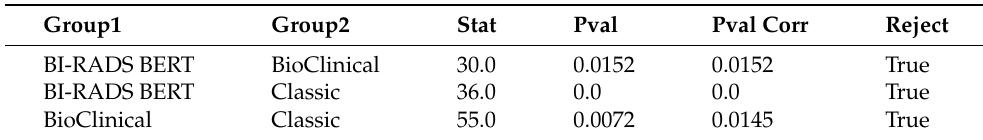
Table A13. Bonferonni-corrected McNemar test results for field extraction with no section segmenta- tion of purpose.